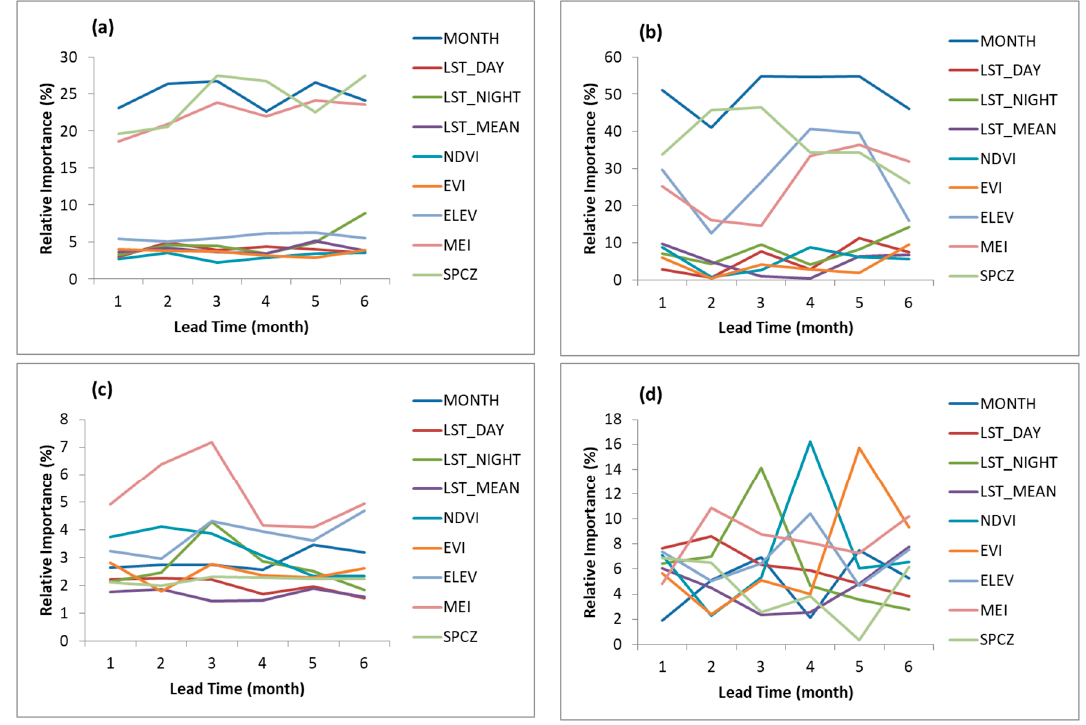
Figure 10. Relative importance scores of input variables to machine learning models for ( a ) ERT_WRF; ( b ) Adaboost_WRF; ( c ) ERT_INSITU; and ( d ) Adaboost_INSITU.